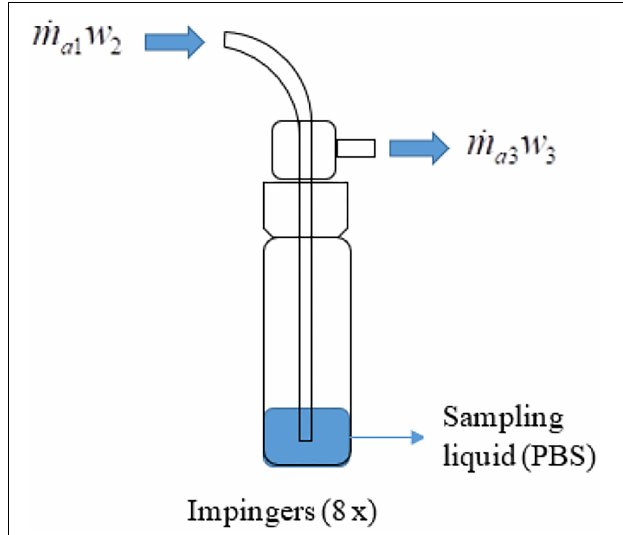
FIGURE 3 | Mass balance of water vapor in the impinger to trap aerosolized virus into sampling liquid. A visual demonstration supplements Eq. (7); the water vapor content arriving in the impinger plus the water vapor content absorbed from the sampling liquid is equal to the water vapor content exiting the